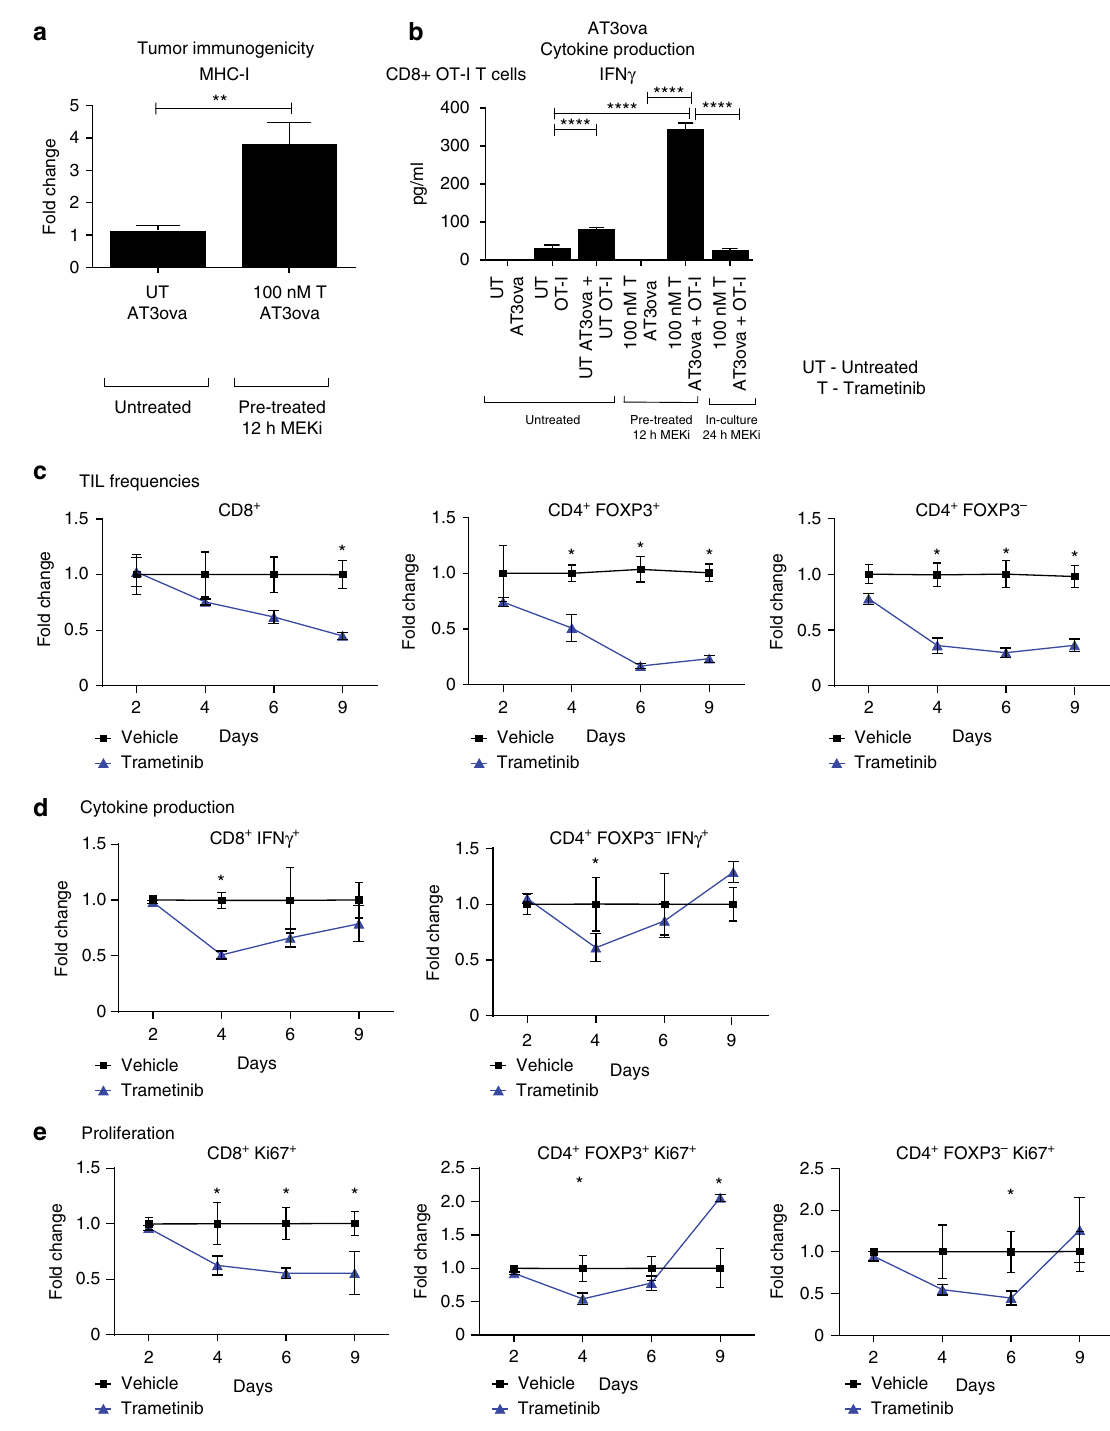
Fig. 3 MEK inhibition increases tumor immunogenicity but reduces T-cell effector functions. Co-culture studies undertaken with AT3ova tumor cells and CD8 + OT-I T cells; 12 h pre-treatment followed by co-culture, or 24 h co-culture with trametinib treatment. a FACS analysis of MHC-I expression of AT3ova tumor cells normalized to non-treated tumors. b IFN γ production from OT-I T cells. c – e Mice ( n = 3 per group) bearing AT3ova tumors were treated with vehicle (PEG 400/solutol) or trametinib (1 mg/kg/daily), and tumors were harvested on day 2, 4, 6, and 9 post treatment. Changes in c TIL frequency (CD8 + , CD4 + FOXP3 − , CD4 + FOXP3 + ) as a proportion of CD45 + live cells, d cytokine production by T cells, and e proliferation of T cells measured by Ki67 expression were determined ex vivo by FACS analysis. Values were normalized to vehicle controls at each time point and data are expressed as fold change for the number of positive cells. Data are presented as mean ± SEM, and is a representative of three independent repeats. P -values represent unpaired t -tests at each time point and post hoc Fisher ’ s LSD tests. * P < 0.05, ** P < 0.01, *** P < 0.001, **** P <